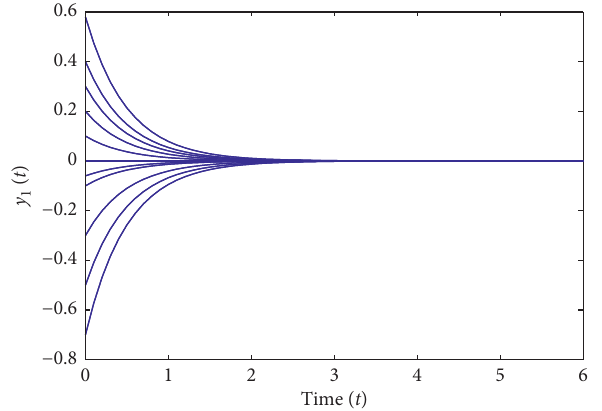
Figure 4: The EGS of r